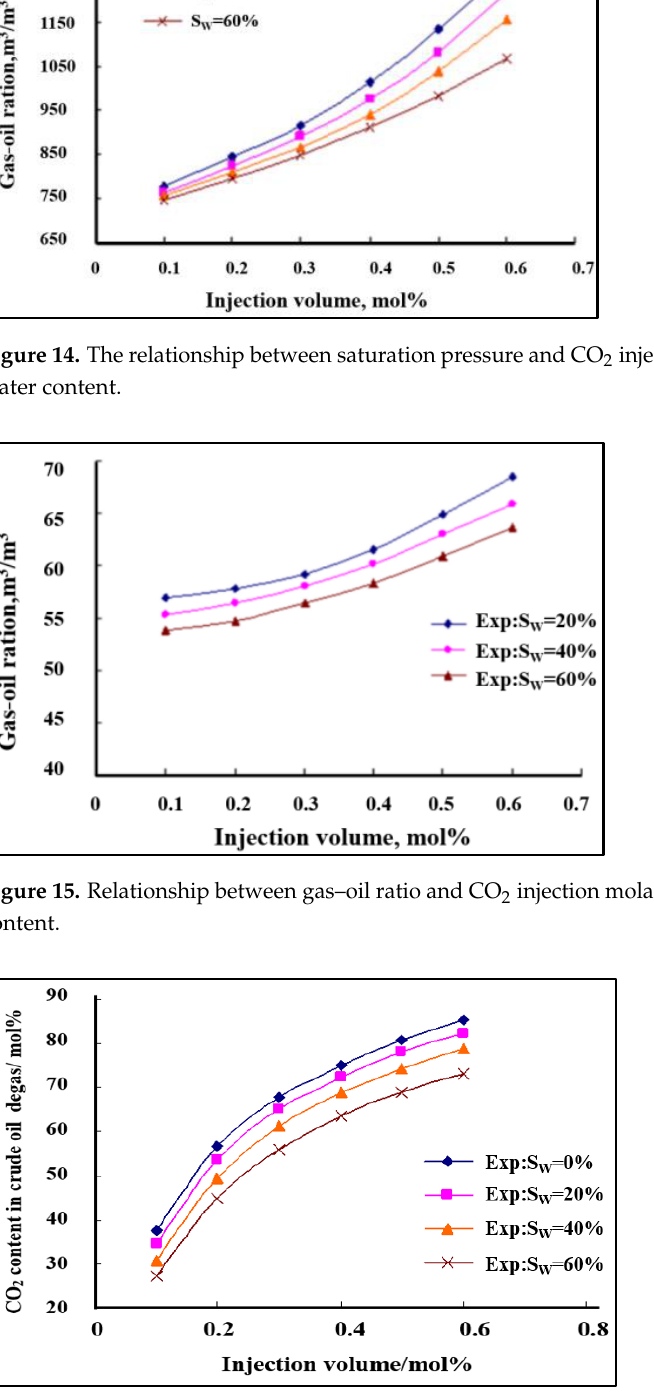
Figure 16. The relationship between the molar content of CO 2 in flash gas of crude oil and CO 2 injection molar quantity at different water contents.